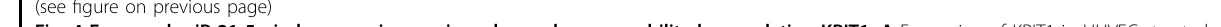
Correlations of miR-21-5p with KRIT1 expression in CRC- adjacent vessels